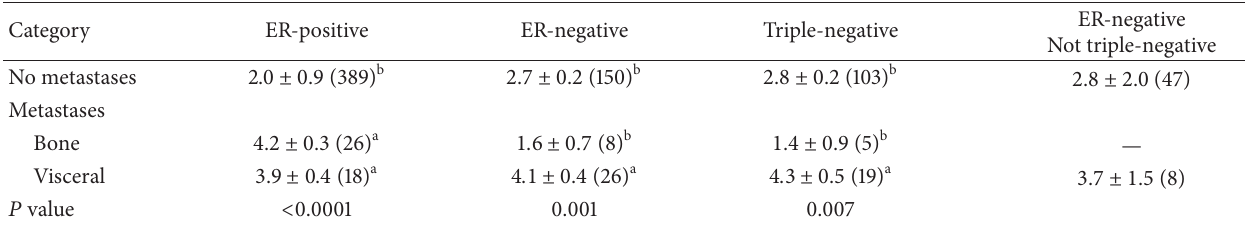
Table 5: Tumor size in relation to ER and triple-negative status †